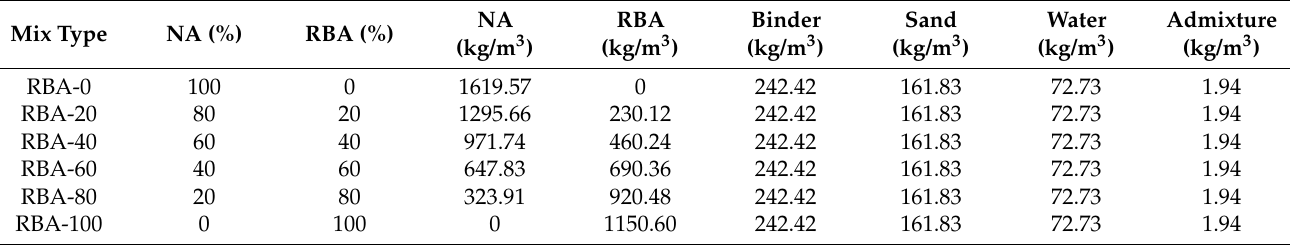
Table 3. Mix proportion of PC mixes.